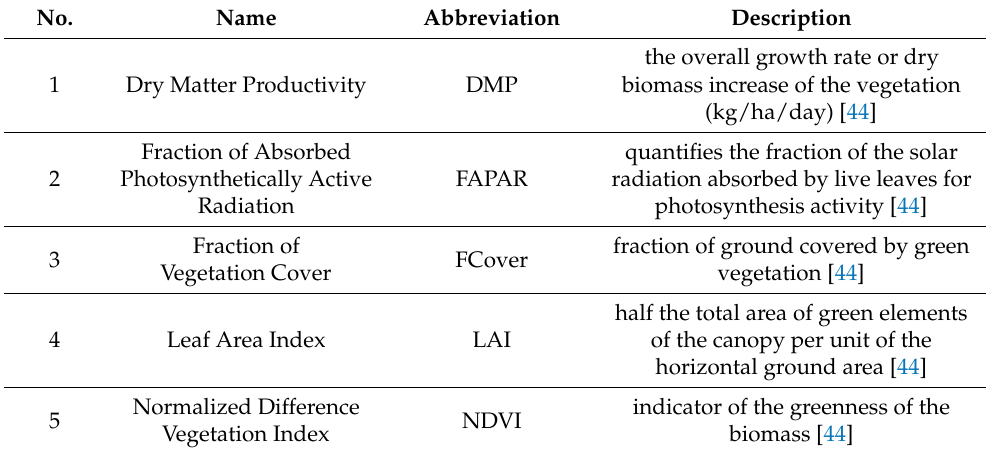
Table 4. Copernicus biophysical parameters used to study leaf